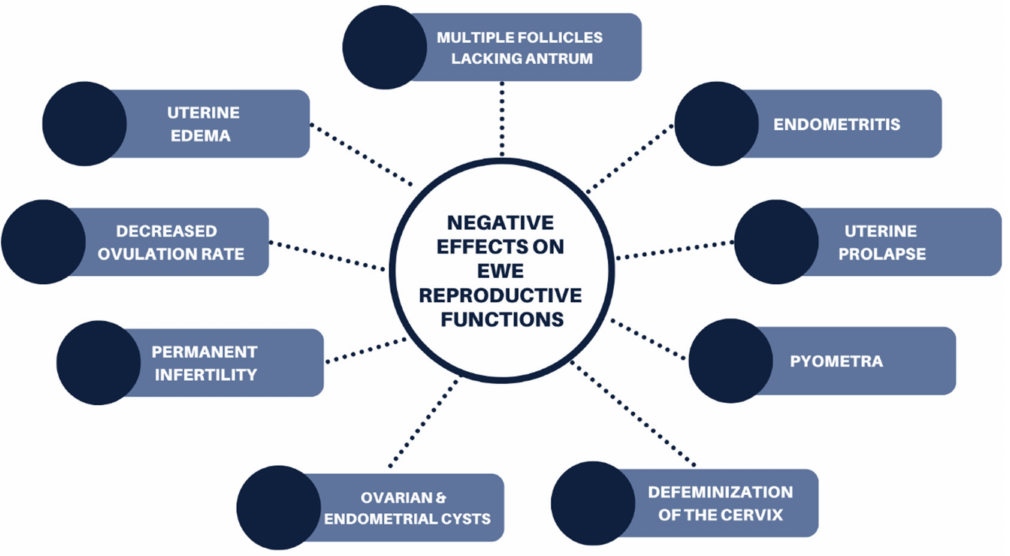
Figure 6. Negative effects of phytoestrogens on ewe reproductive functions from legume pasture